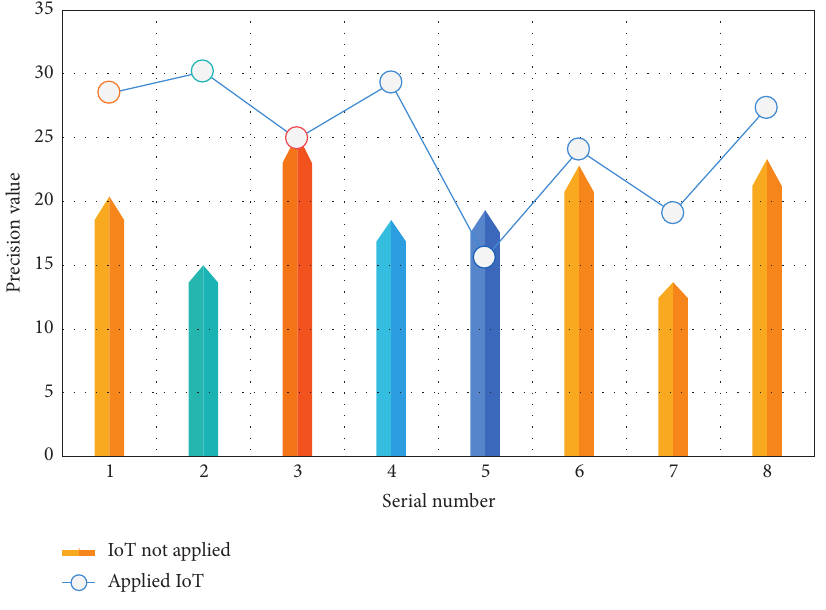
Figure 9: The accuracy of the alarm system. Table 4: Comparison results of performance indicators of three control